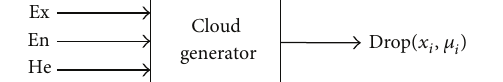
Figure 8: Digital features of cloud.